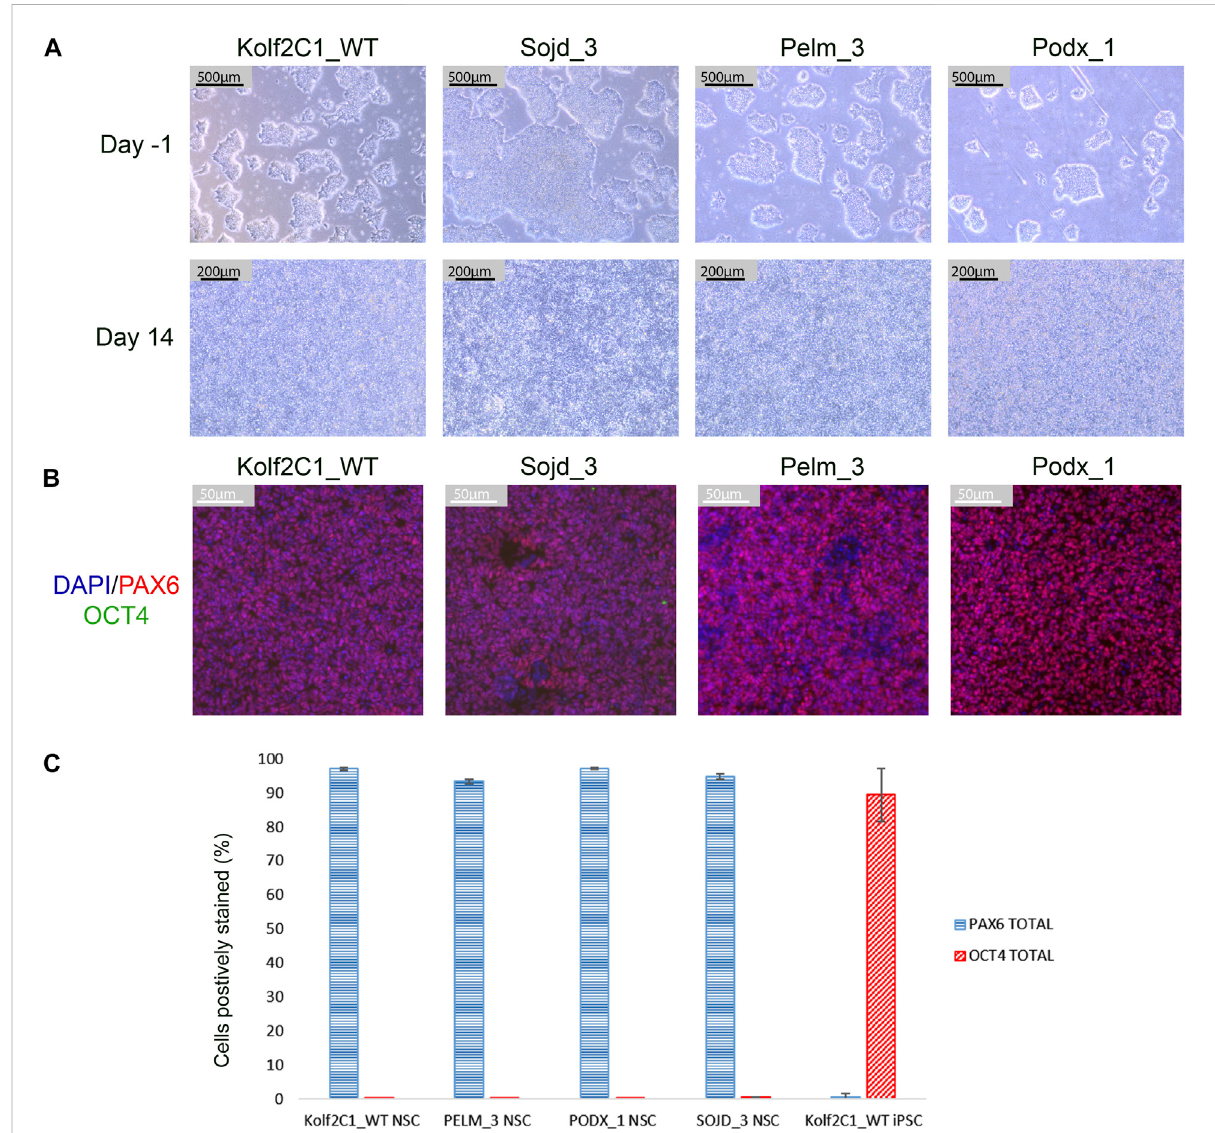
FIGURE 11 Differentiation outcomes of additional iPSC lines. (A) Bright fi eld images for Kolf2C1_WT, Sojd_3, Pelm_3 and Podx_1 on Day -1 prior to the NeuralInductionpassage(Scalebar500 μ m,5x),andonDay14priortocryopreservation(Scalebar,200 μ m,10x).NotethatSojd_3Day-1imagehas a different sized scale bar (200 μ m) but the magni fi cation is the same. (B) Immunocytochemistry images showing PAX6, OCT4 and DAPI staining of NSCs generated from all four iPSC lines (Scale bar 50 μ m, 20x). (C) Quanti fi cation of immunocytochemistry results, displaying the mean percentage of cells positively stained with PAX6 and OCT4 for each cell line. Error bars represent ±